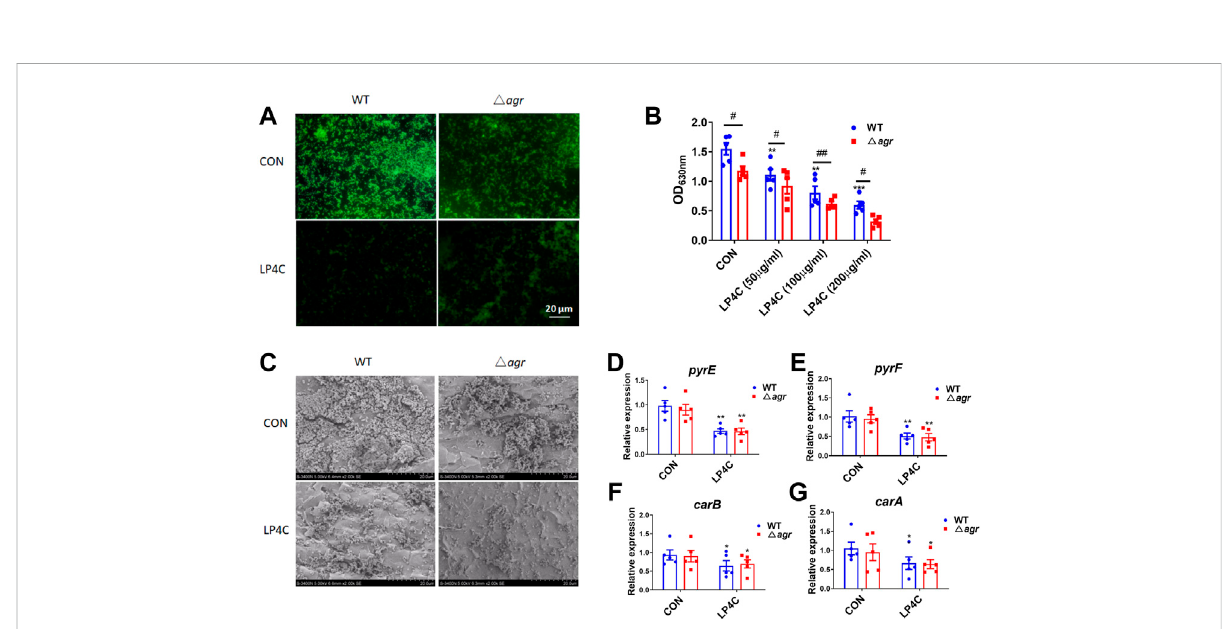
Agr QSS is not involved in the inhibitory activity of LP4C. Immuno fl uorescence staining of wild type (WT) and agr de fi ciency ( Δ agr) MRSA USA300 in control (CON) or LP4C treatment (A) . Morphological observation of bio fi lm structure and bacteria number of WT or Δ agr MRSA USA300 under the SEM after LP4C treatment (B) . The effect of LP4C (50, 100 and 200 μ g/ml) to the formation of WT and Δ agr MRSA USA300 by crystalvioletstaining,** p < 0.01,*** p < 0.001vs . control(CON), # p < 0.05, ## p < 0.01vs . Δ agrgroup,n=5 (C) .TheeffectofLP4C(100 μ g/ml)to the gene expression of WT and Δ agr MRSA USA300, * p < 0.05, ** p < 0.01 vs . control (CON), n = 5 (D – G)